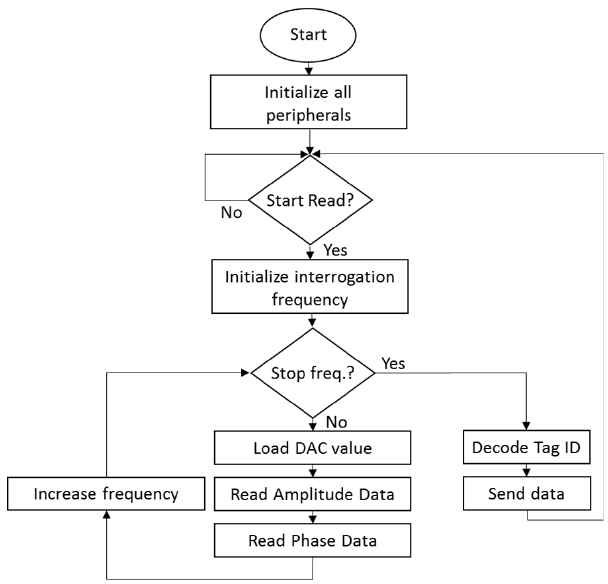
Figure 3. Firmware sequences of the portable reader for frequency domain chipless tags.